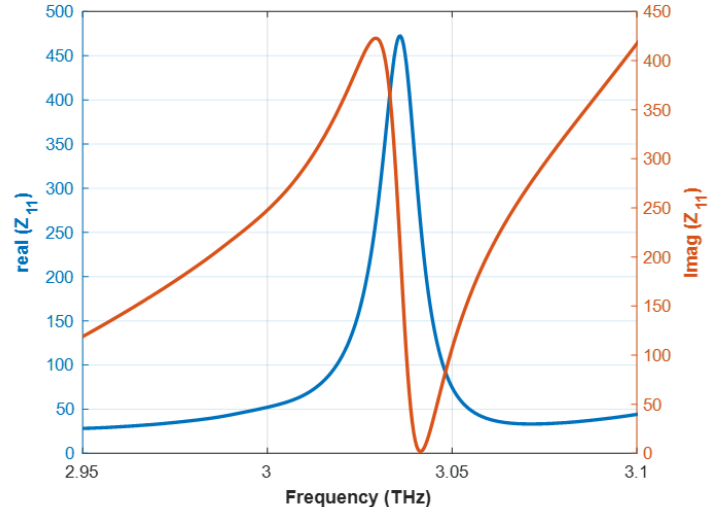
Figure 10. Impedance of the proposed